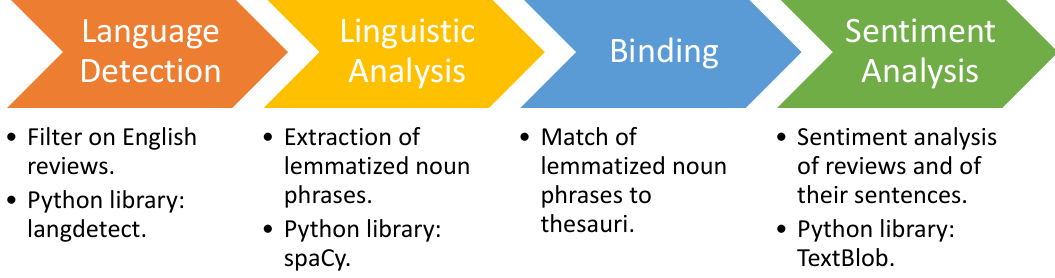
Figure 2. Pipeline of activities for the analysis of an individual